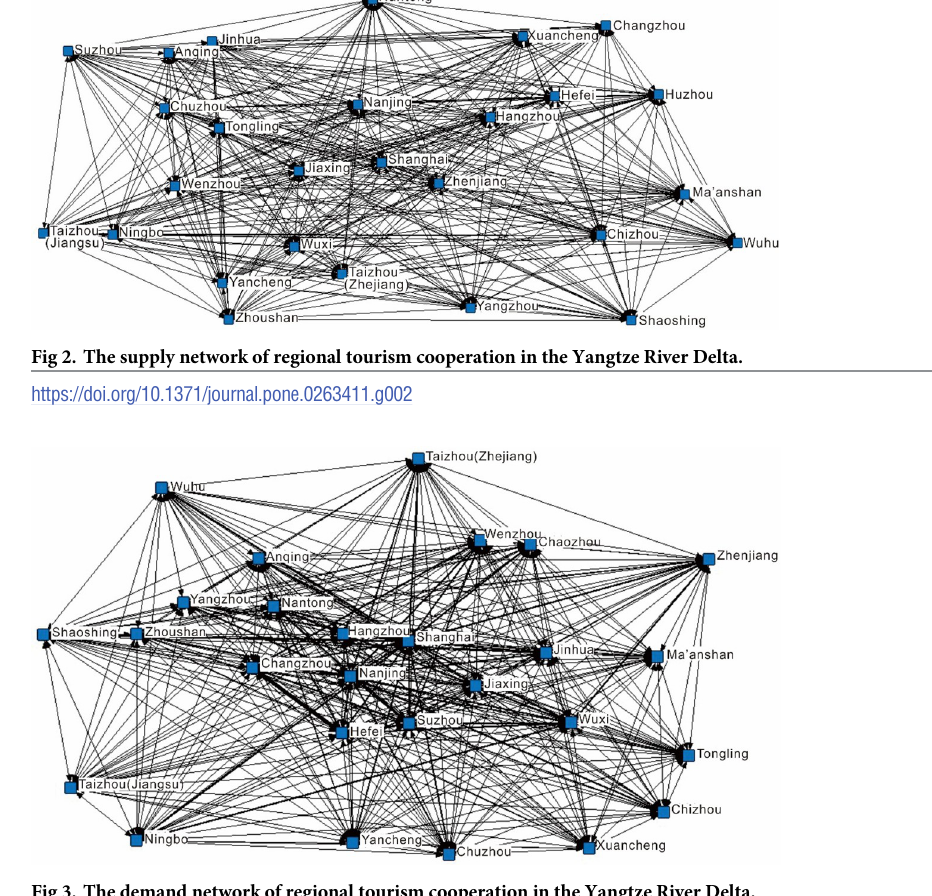
members of the network, and only four in the supply network. In the supply network, Shang- hai, Nanjing, Suzhou, and Hangzhou have been the focus of government and tourism enter-